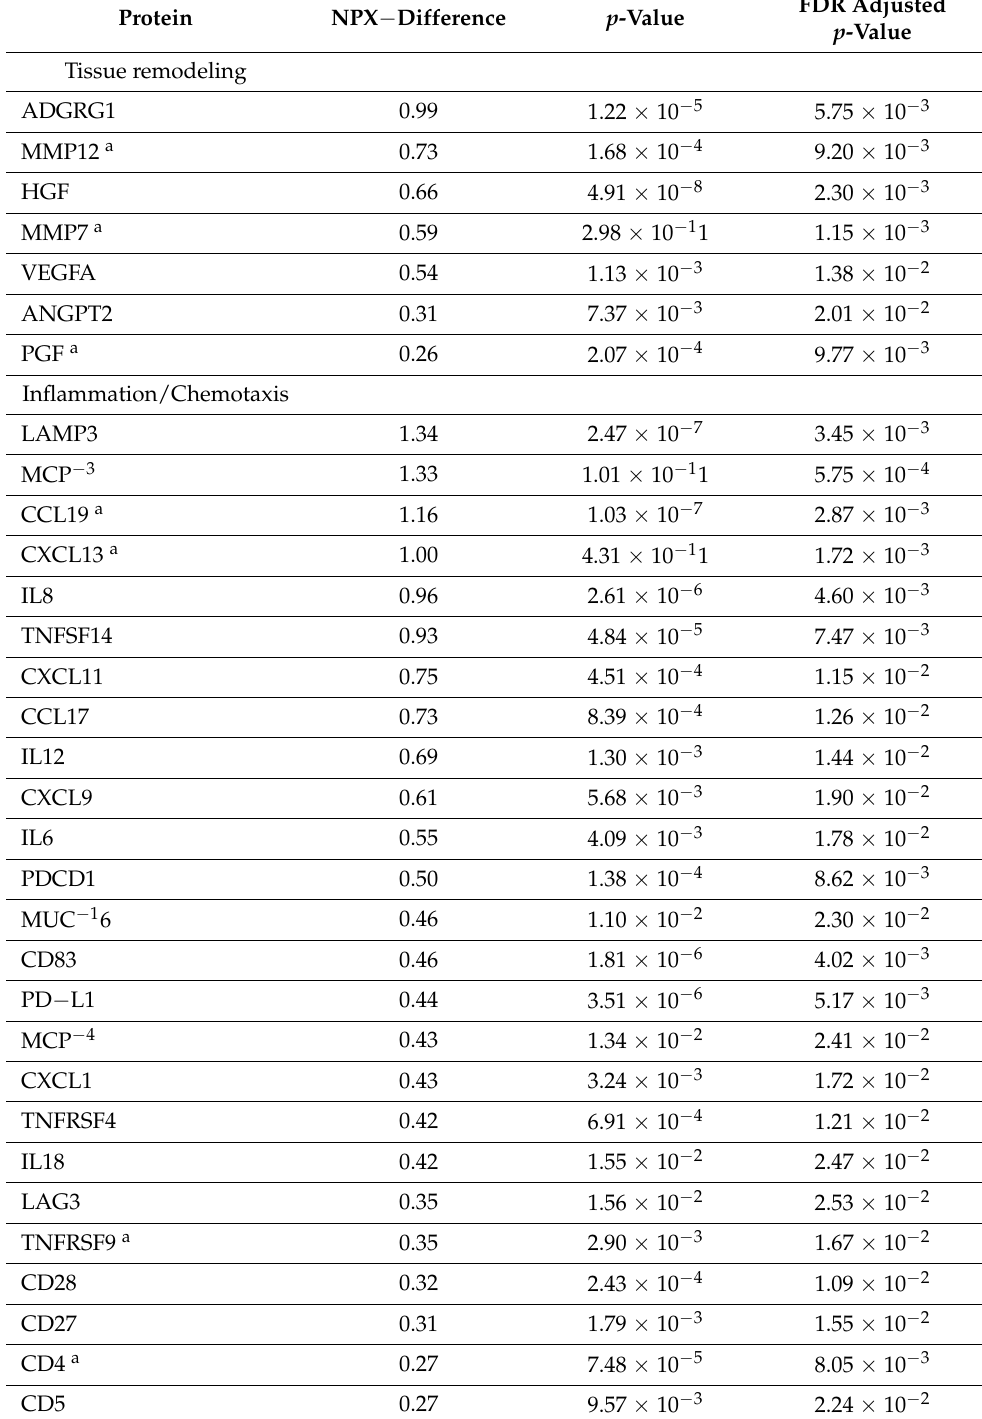
Table 3. Elevated proteins at IPF baseline overlap with findings ex vivo. Proteins with differ- ences in concentration (normalized protein expression, NPX) in baseline sample from IPF patients versus controls, categorized into two main biological function, tissue remodeling and inflamma- tion/chemotaxis. Seven proteins were judged as having overlapping functions. a indicate proteins with differentiated expression observed in the ex vivo model. One-way ANOVA adjusted for age with Benjamini–Hochberg corrected p -value to control a false discovery rate at